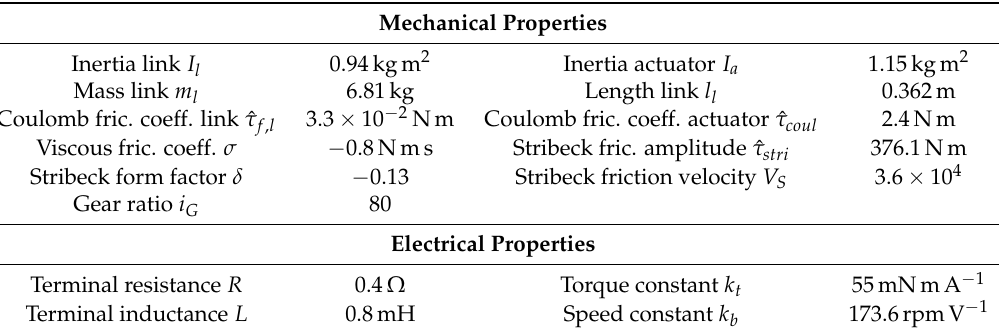
Table 1. Parameters of the VTS actuator